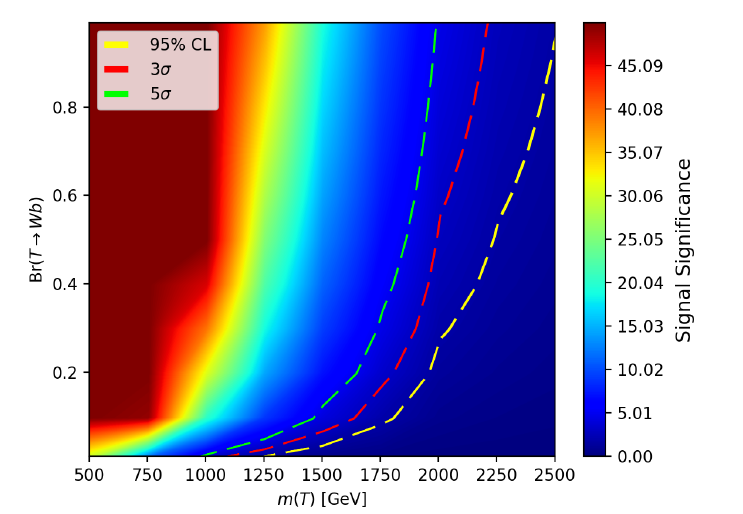
JHEP03(2023)164